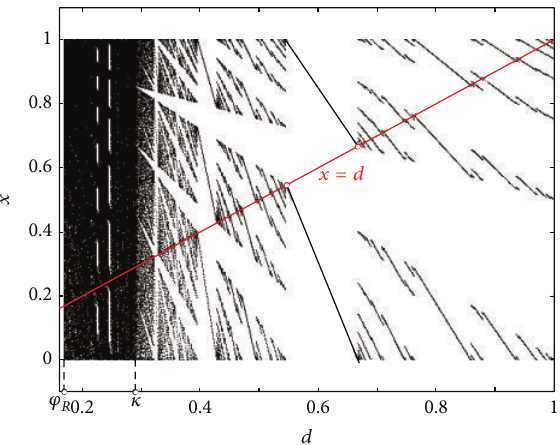
Figure 6: 2D bifurcation diagram of map plane for 𝑎 𝐿 = 0.5 .